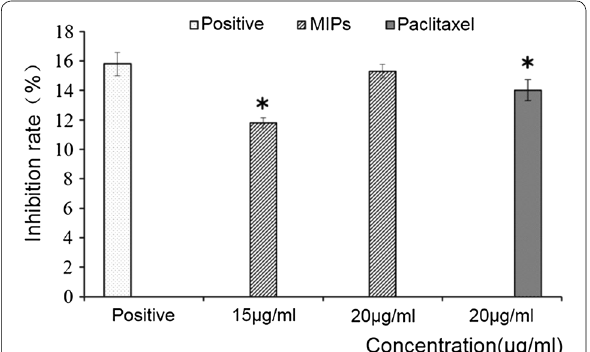
Fig. 6 Inhibitory effects of different concentrations of paclitaxel, MIPs